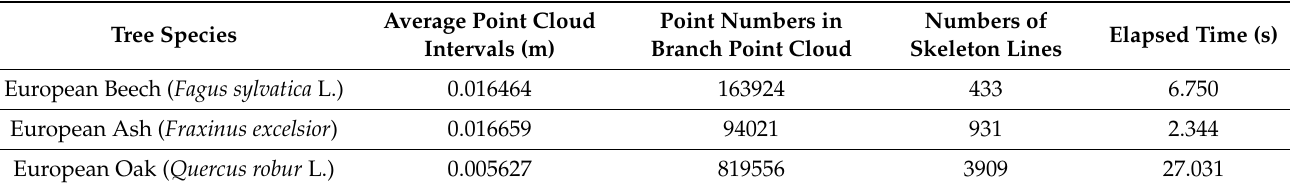
Table 4. Detailed parameters of produced